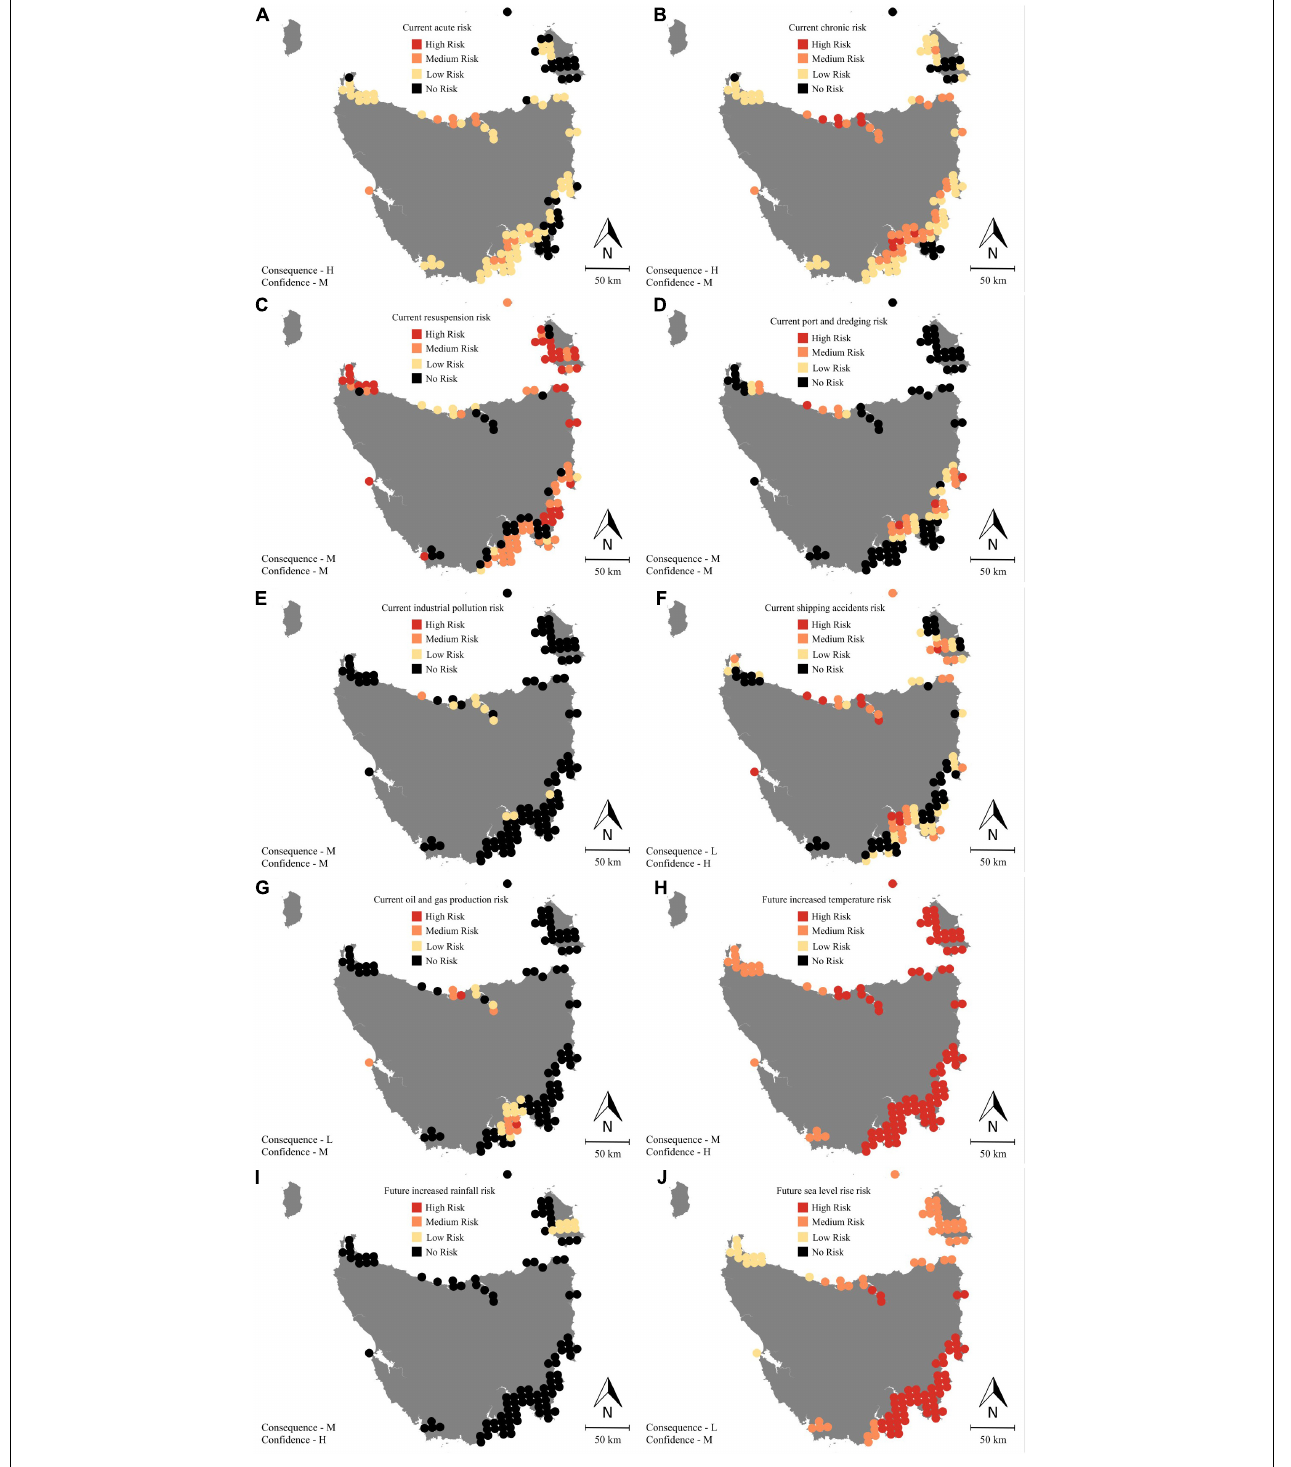
FIGURE 3 | An example of how spatially explicit current (A–G) and future (H–J) threats were applied to Tasmania (10 km × 10 km grid cells). Only cells where seagrass is present are shown. The risk of each threat was categorized as high, medium, low or no risk if there was no exposure to that threat. Each threat was weighted based on the consequence of exposure to this threat and the confidence in the threat was assessed through a survey with experts.